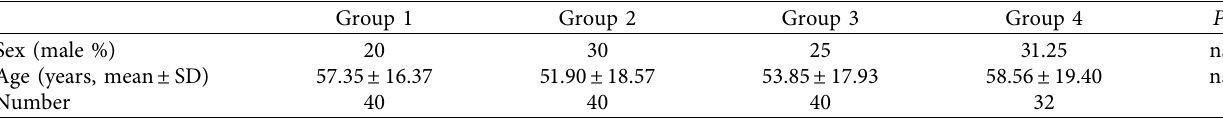
Figure 1: Treatment 1 (group 1): only artificial tears; treatment 2 (group 2): corticosteroids and artificial tears; treatment 3 (group 3): oral vitamin B1, mecobalamin, and artificial tears; treatment 4 (group 4): oral vitamin B1, mecobalamin, corticosteroids, and artificial tears. Table 1: Basic